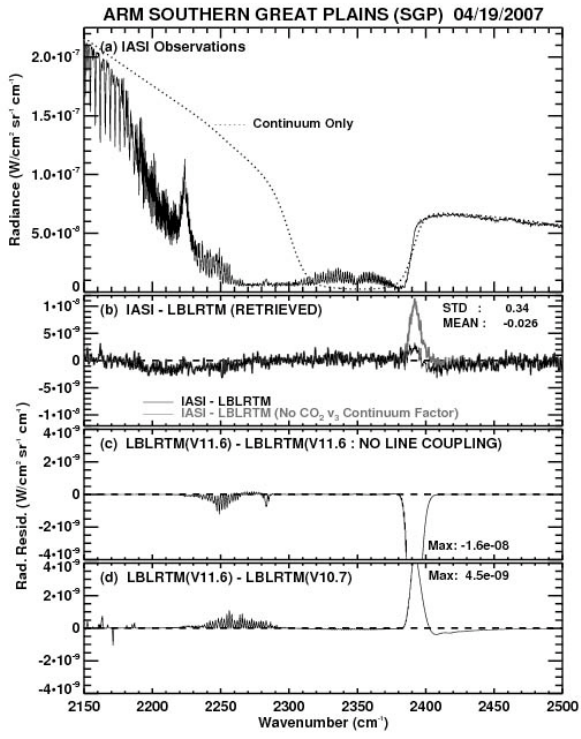
Fig. 17. (a) IASI radiance spectrum in the CO 2 n 3 region (2150–2500cm − 1 ) for the land case, showing the contribution from the continuum. (b) IASI/LBLRTM final radiance residu- als (solid line), also showing the residual resulting from a ver- sion of the continuum that does not include an empirical correc- tion around 2385cm − 1 (dash-dotted line). (c) Model/model ra- diance differences: LBLRTM v11.6 (P, Q, and R line coupling, MT CKD v2.4, and chi=1) minus LBLRTM V11.6 (no line cou- pling, MT CKD v2.4, and chi=1). (d) Model/model radiance differ- ences: LBLRTM v11.6 (P, Q, and R line coupling, MT CKD v2.4, and chi=1) minus LBLRTM v10.7 (old Q-branch line coupling, old continuum and the older chi